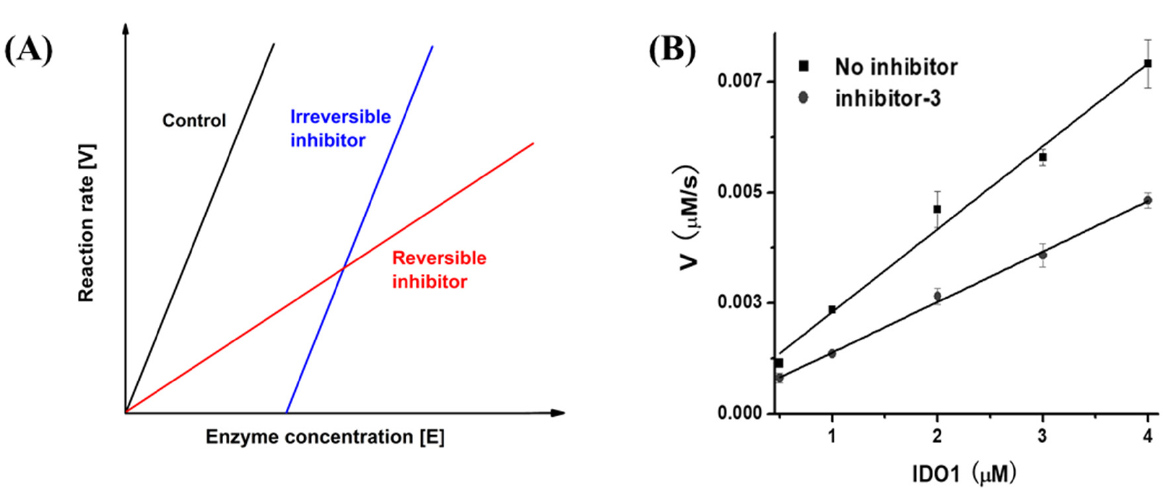
Figure 4. Determination of inhibition types. ( A ) The evaluation standard of inhibition type. The plot is enzymic reaction rate [V] against enzyme concentration [E]. The plot represents that curves with different slopes determine the inhibition type: reversible (in red color) or irreversible (in blue color) [31]. ( B ) An example for inhibition type determination with inhibitor 3 . The slope of inhibitor 3 is consistent with the reversible inhibition type. Three independent assays were performed and the data are presented as mean ± SD with three independent assays.